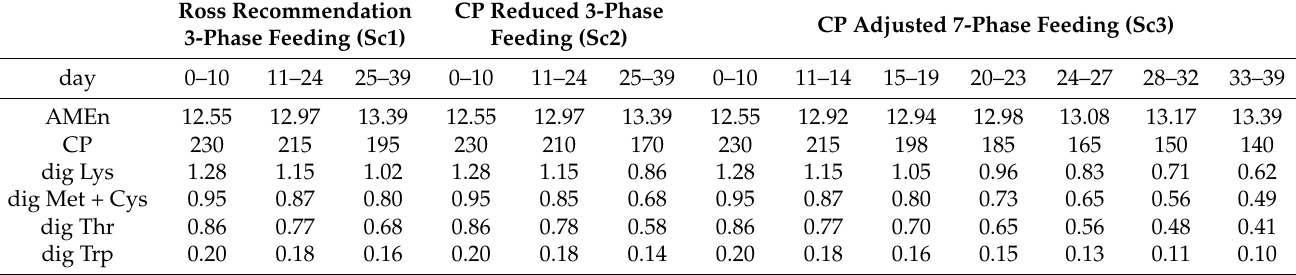
Table 1. Nutrient content of feeds used in different feeding schedules, in Sc1 feeding schedule recommended by Aviagen for Ross 308 (3-phases), in Sc2 feeding schedule adjusted to the simulated crude protein requirement (3-phases), and in Sc3 feeding schedule with smoother adjustment of protein requirement